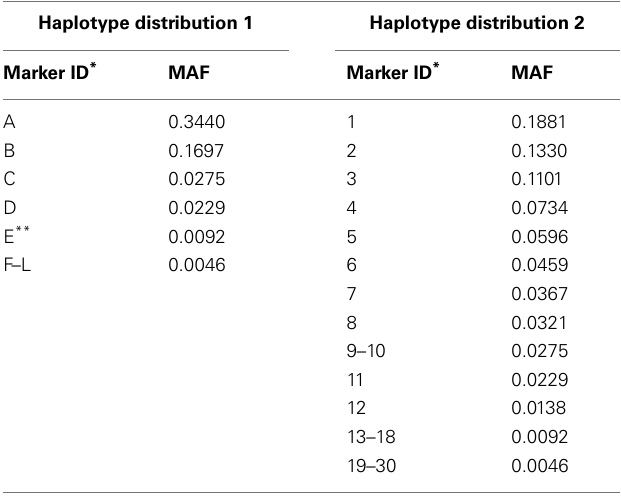
Table 1 | Minor allele frequency (MAF) of markers resulting from sequencing data from the CHB sample of 1000 Genomes